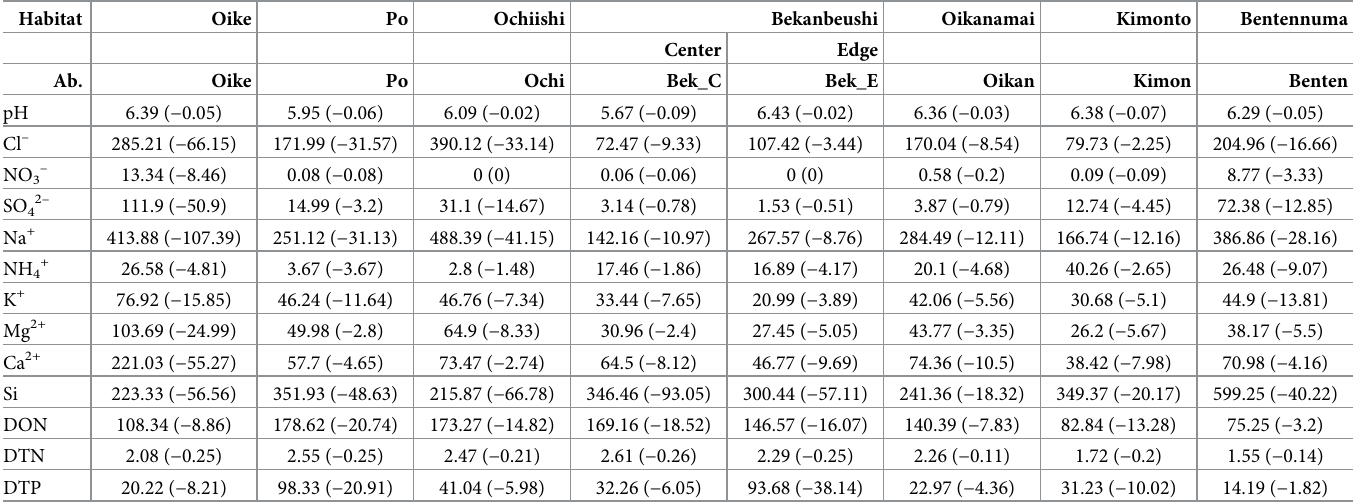
Table 1. Summary of chemical analyses of soil water in eight habitats of Myrica gale . Habitat